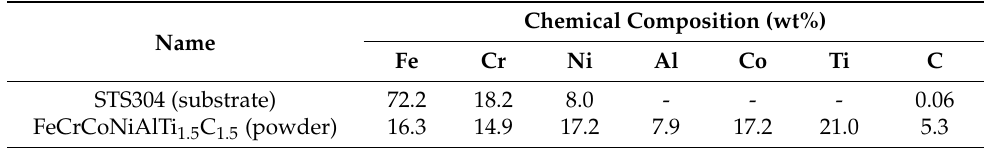
Figure 1. ( a ) schematic of the experimental setup. ( b ) HEAs powder dried on the substate before laser cladding. ( c ) Coating layer appearance after laser cladding. Table 1. Chemical compositions of substrate and